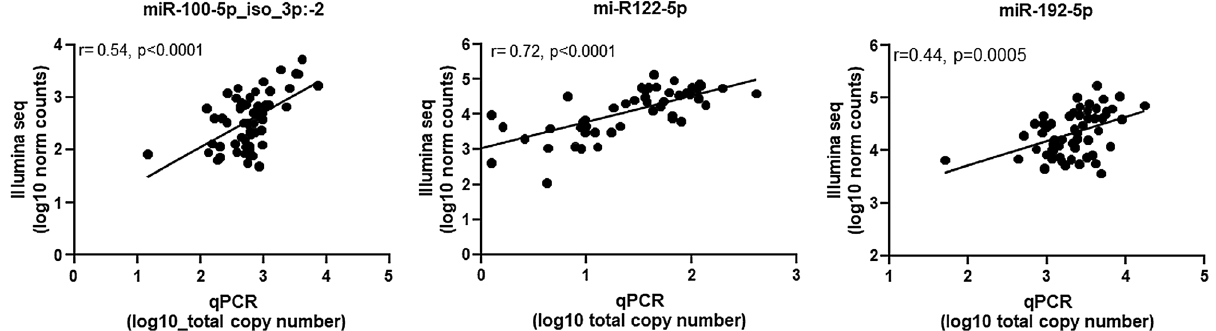
Figure 4. Correlation of plasma miR-100-5p_iso_3p:−2, miR-122-5p, and miR-192-5p levels determined by RT-qPCR and Illumina large-scale deep sequencing analysis. Sequence reads of the miR-100-5p_iso_3p:−2 variant and those from the canonical miR-122-5p and miR-192-5p quantified by large-scale deep sequencing on 57 plasma samples obtained from individuals coinfected with HIV-1/HCV and uninfected healthy controls, correlated with the study RT-qPCR assay results. Correlation between the two datasets was good for each of the three miRs analysed. Pearson correlation was used for statistical analyses.